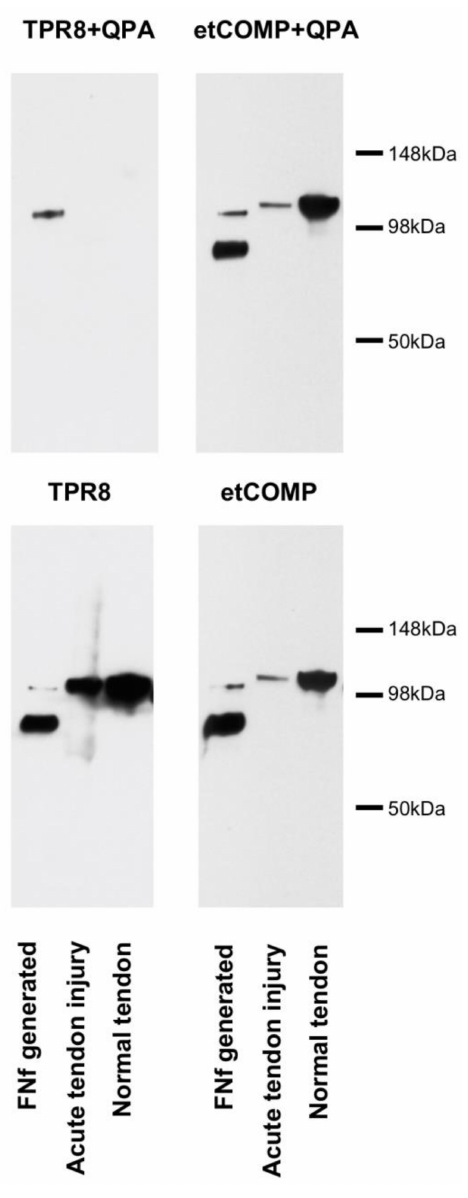
Figure 5. Identical western blots of 4–16% SDS-PAGE gels run under reducing conditions, probed with a polyclonal antibody raised against equine COMP purified from equine tendon (etCOMP) neoepitope polyclonal antiserum (TPR8), with (top row) and without (bottom row) the spanning peptide (QPA) to reduce cross-reactivity of the neoepitope anti-serum to non-cleaved COMP molecule. Note the addition of the spanning peptide has minimal e ff ect on the labelling with the polyclonal antiserum to the whole molecule, while it blocks binding of the neoepitope antiserum to all other COMP bands apart from the ~100 kDa fragment from which the neoepitope antiserum was